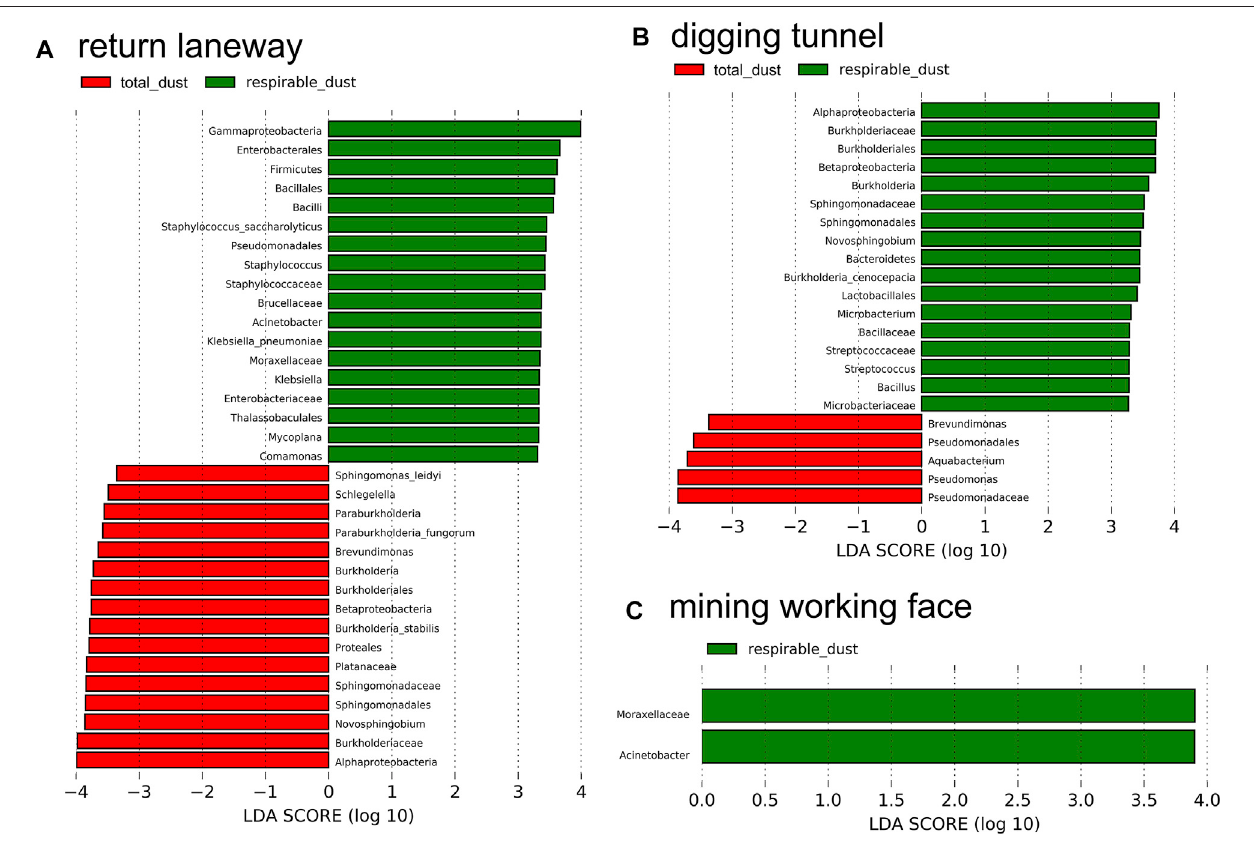
FIGURE5| Lineardiscriminantanalysis(LDA,thresholdof3.0, p < 0.5)forhigh-dimensionalbiomarkersinreturnlanway (A) ,diggingtunnel (B) andminingworking face (C) . And there was no high-dimensional biomarker in intake air fl ow roadway between the total dust and the respirable dust.